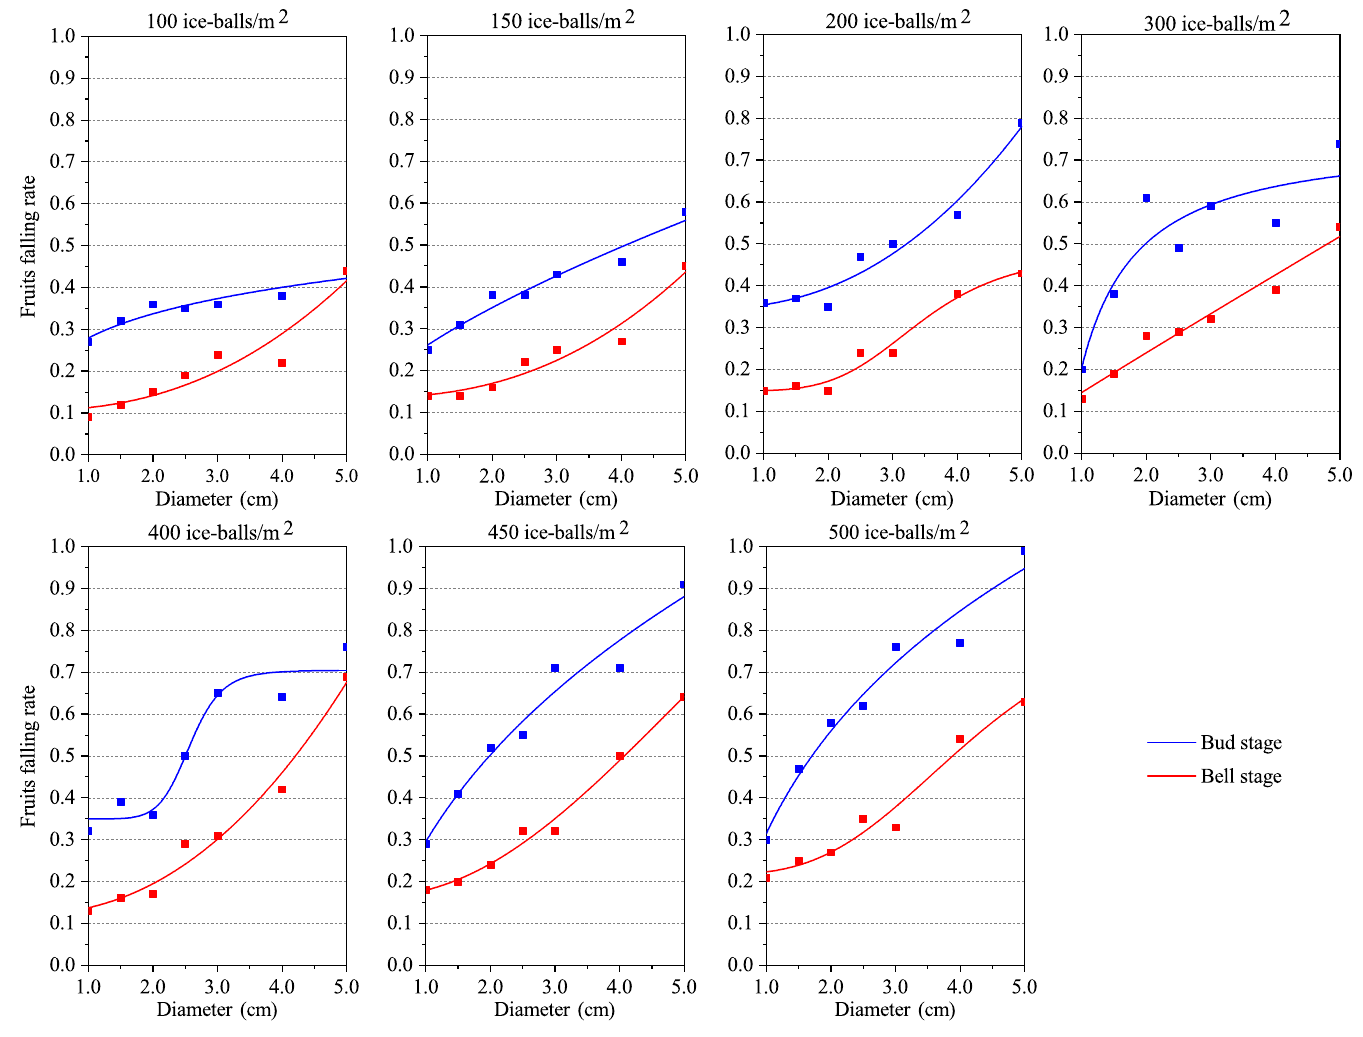
Fig 3. Logistic relationship between the boll falling rate and hail